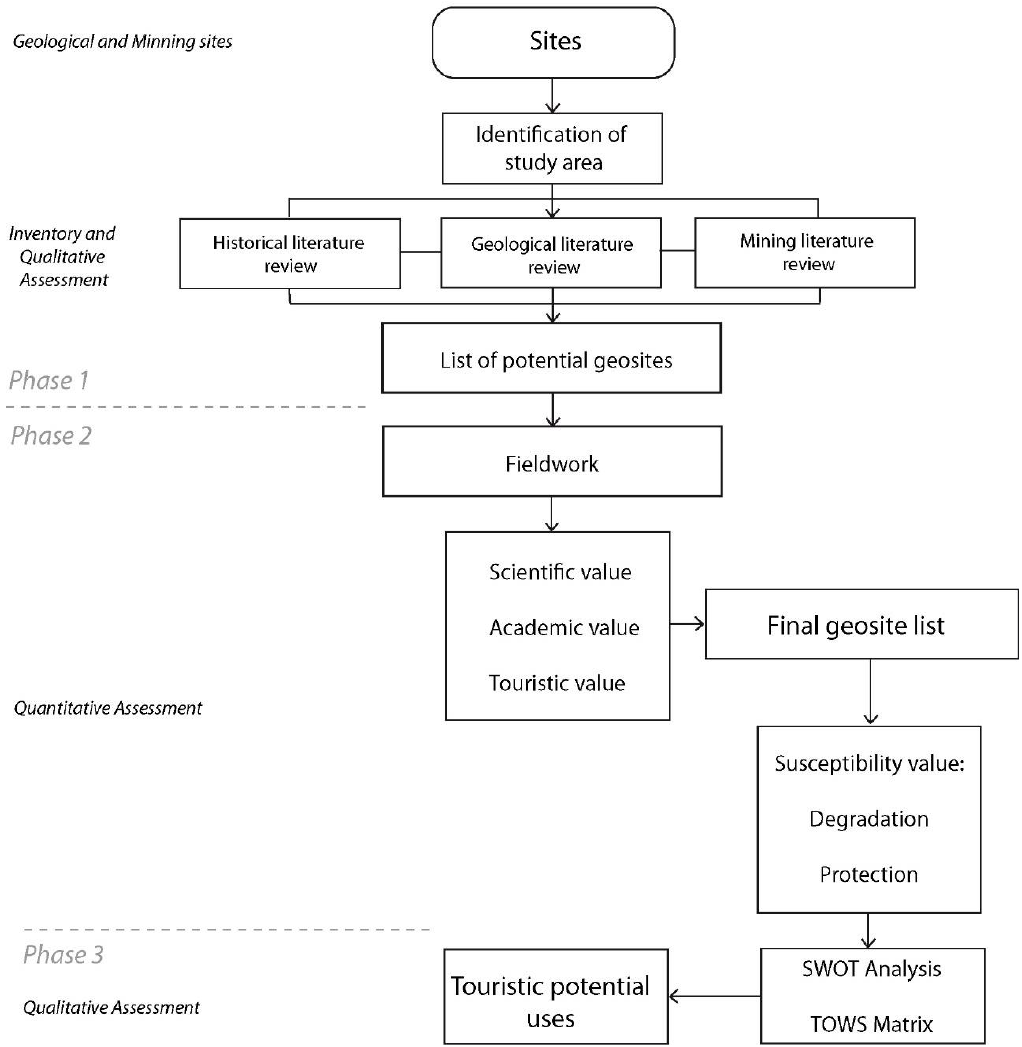
Figure 3. Scheme of the methodology used for the assessment of the sites (geosites and mining sites). Modified from [ 12,33 ] . SWOT (Strengths, Weaknesses, Opportunities, Threats). TOWS (Threats, Opportunities, Weaknesses, Strengths).